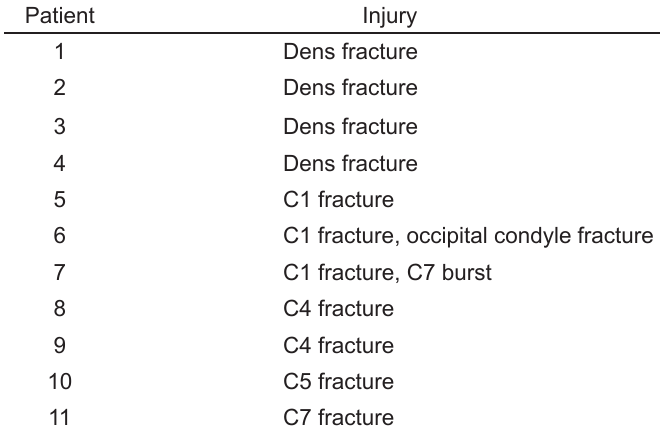
Table 2. Cervical spine injuries in elderly fall patients.